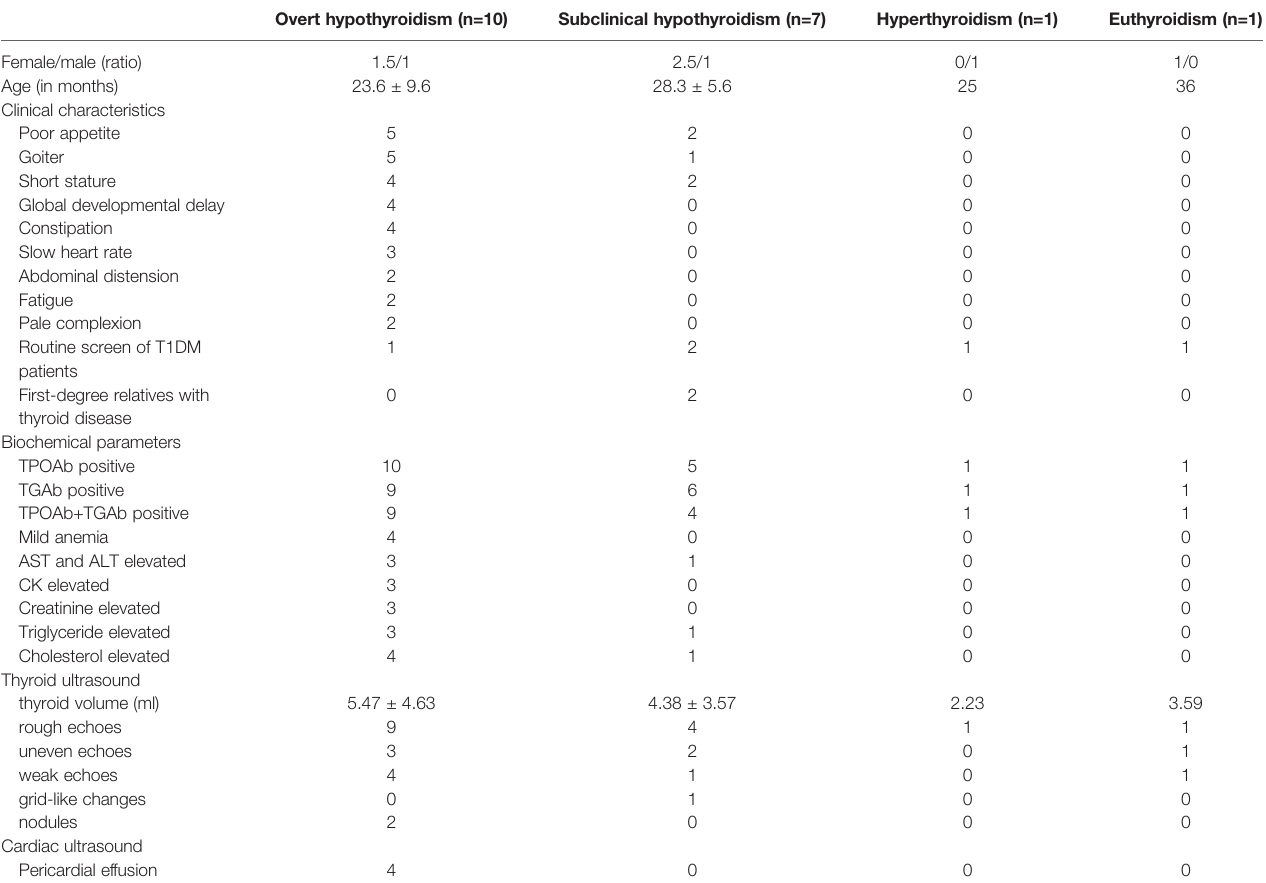
TABLE 2 | Characteristics of the four subgroups at diagnosis.